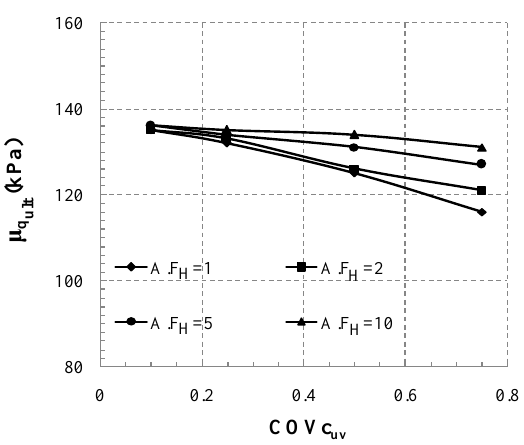
Fig. 8. Effect of heterogeneity anisotropy on ultimate bearing